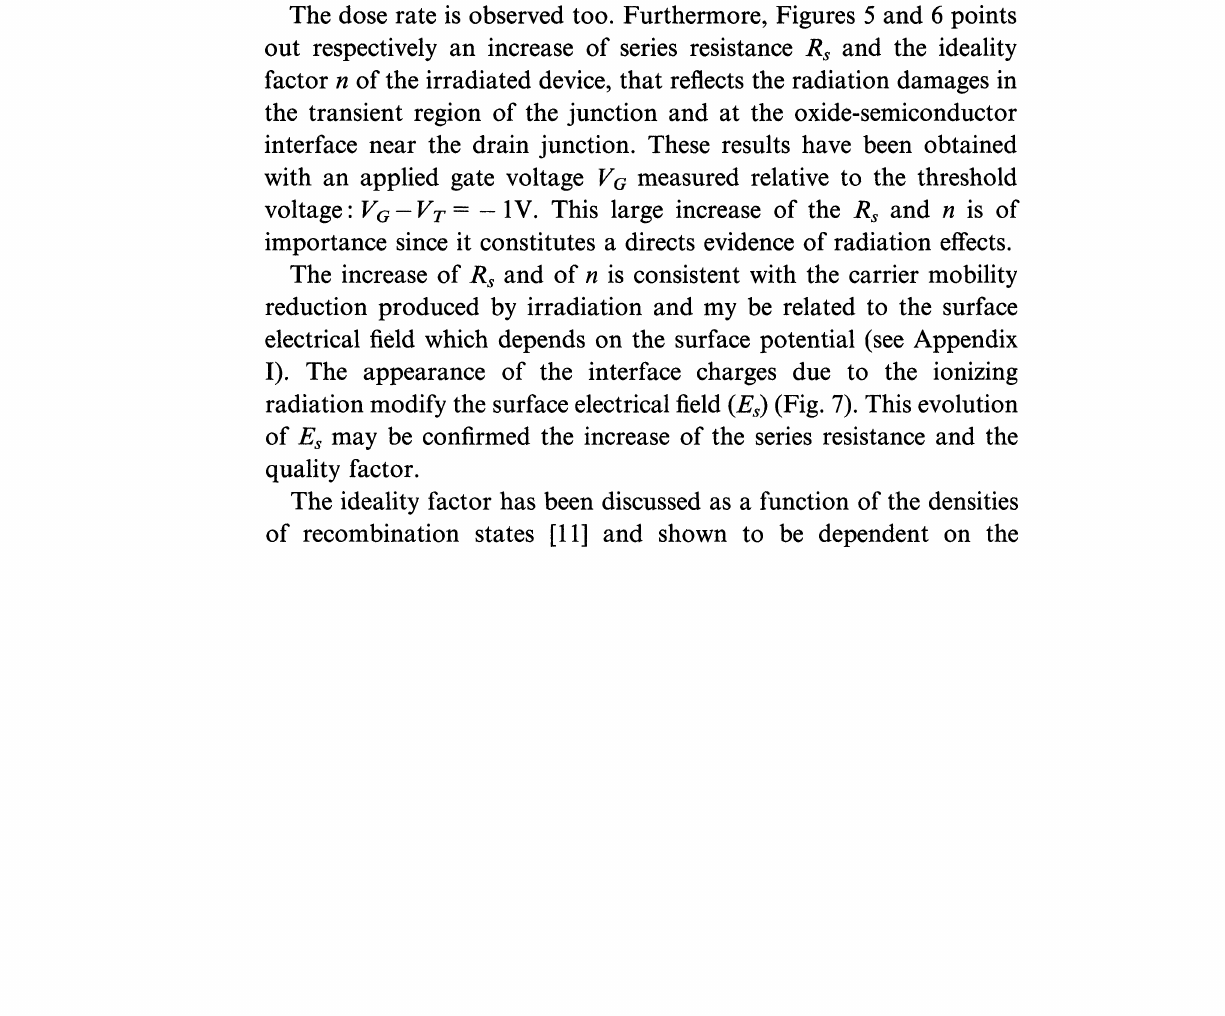
FIGURE 4 Variation of the series resistance, R, against gate bias V calculated before (NI), and after (IR)